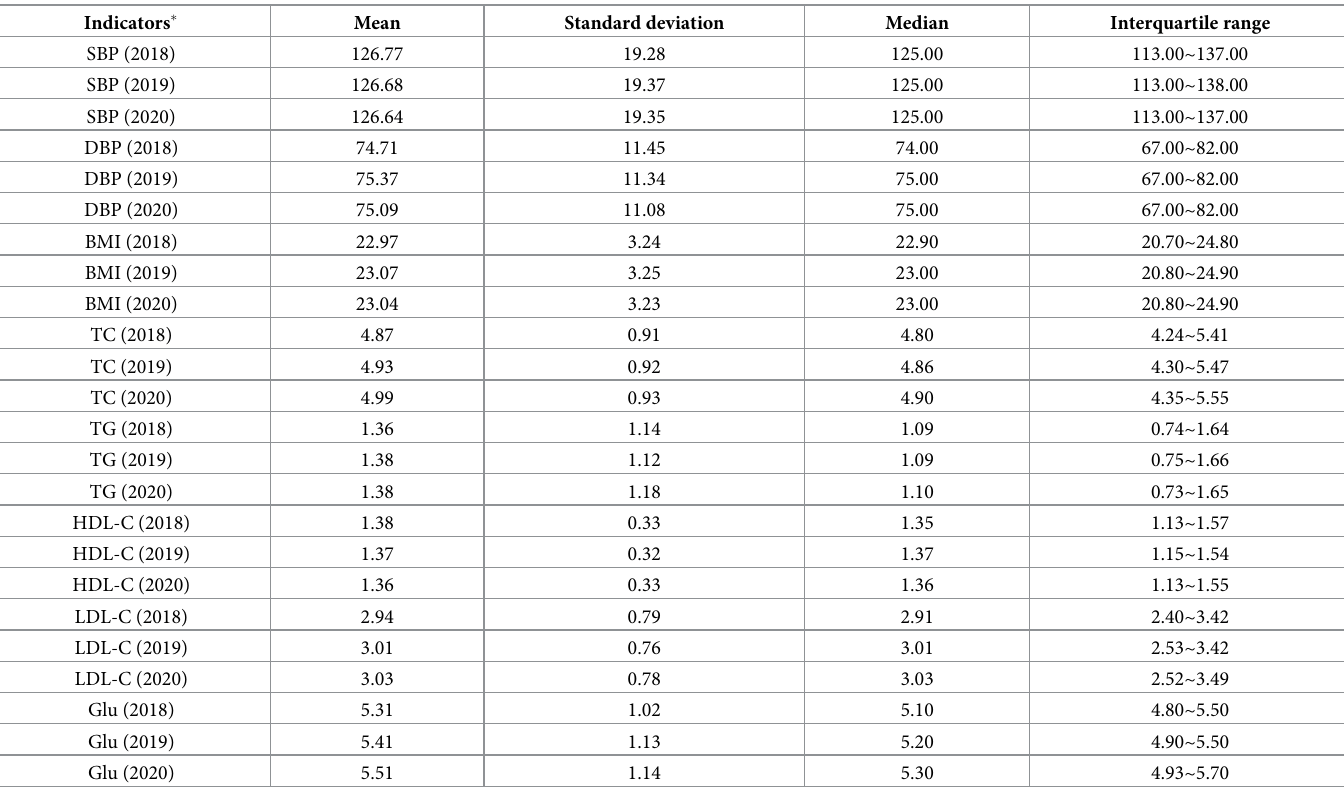
Table 2. Characteristics of cardiovascular health